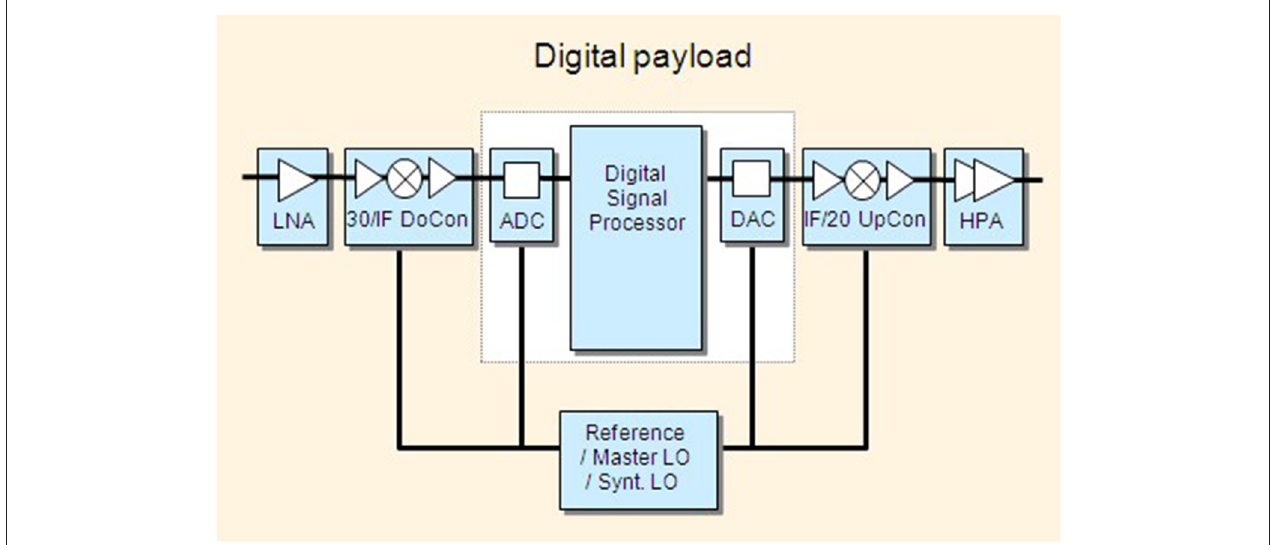
FIGURE 1 | Functional architecture of a digital processor-based telecom